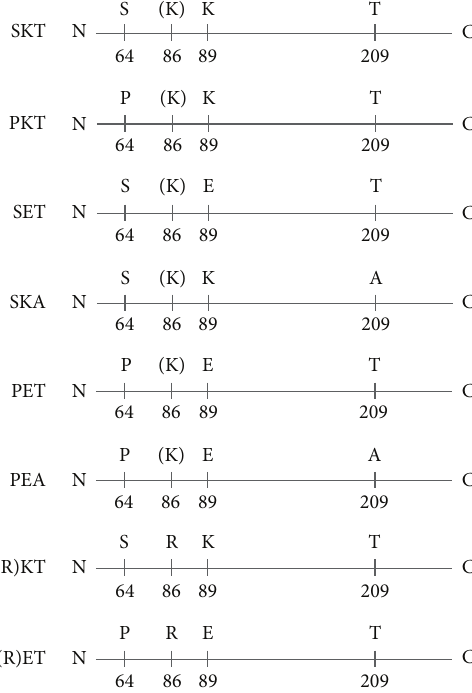
Figure 3: Nature of the M protein motif present in the different Moraten